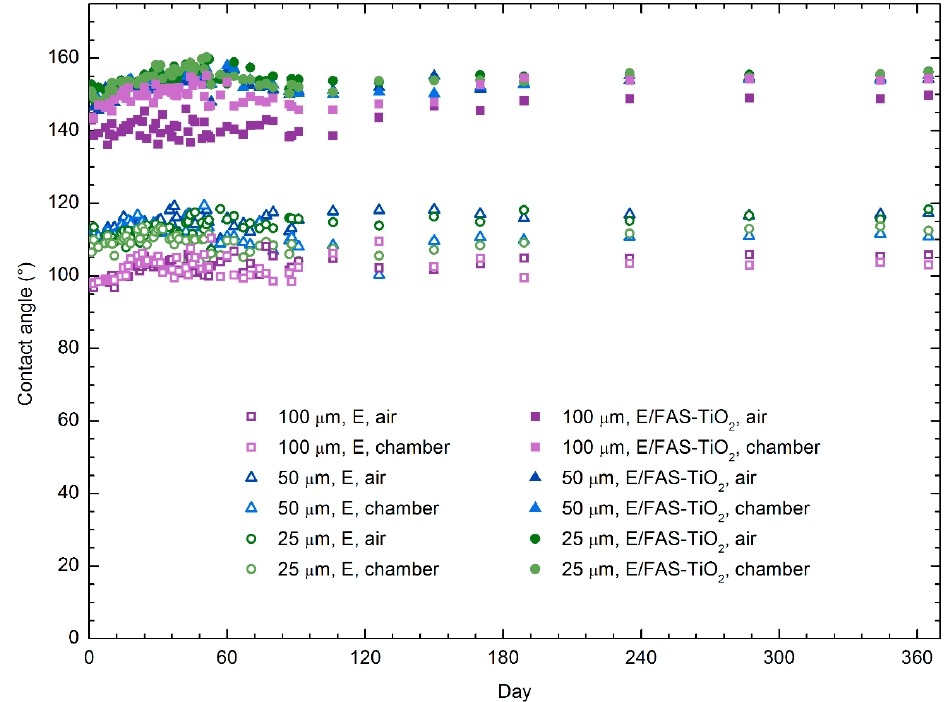
Figure 6. Time development of static water contact angles of epoxy-coated and FAS-TiO 2 /E-coated laser-textured steel surfaces for different scan line separations ( ∆ x = ∆ y = 100, 50, 25 μ m) stored in ambient conditions and in a chamber with reduced air pressure and humidity. Table 3. Comparison of static water contact angles of uncoated, epoxy-, and FAS-TiO 2 /E-coated